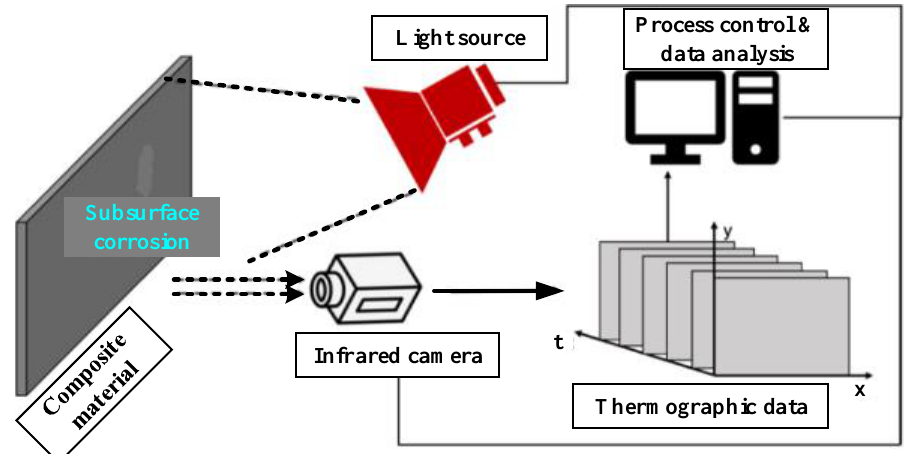
Figure 11. Thermography setup for corrosion detection and monitoring